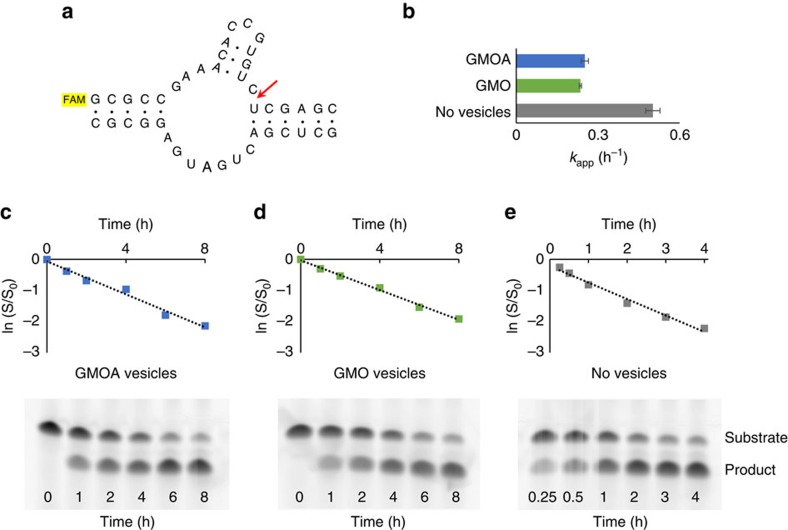
OA/GMOA and OA/GMO vesicles support ribozyme activity.Fluorescein-labelled hammerhead ribozymes (a) were encapsulated within OA/GMOA- and OA/GMO-containing vesicles. Cleavage rates for this ribozyme were measured in both types of vesicles as well as in the absence of vesicles. At 15 mM Mg2+, OA/GMOA vesicles gave similar ribozyme cleavage rates to OA/GMO-containing vesicles (b–e) Green markers: OA/GMO vesicles, kapp=0.24 h−1 (s.e.m.=0.004); blue markers: OA/GMOA vesicles, kapp=0.25 h−1 (s.e.m.=0.013); grey markers: no vesicles, kapp=0.50 h−1 (s.e.m.=0.026). Representative polyacrylamide gel electrophoresis (PAGE) analyses of hammerhead ribozyme reactions for each set of vesicle conditions are shown below each graph. Error bars on b are s.e.m. (n=3). Solid lines on c,d and e are linear fits; for all, R2>0.98. All reactions contained vesicles comprised of 50 mM total lipid (50 mM OA, or 42.5 mM OA, 7.5 mM (15 mol%) GMO or GMOA), and 0.2 M Na-glycinamide, pH 8.5 as buffer, RNA concentration was 1 μM of each hammerhead strand. Mg2+ was present at 15 mM. Reactions were performed at uncontrolled room temperature (20±2 °C).